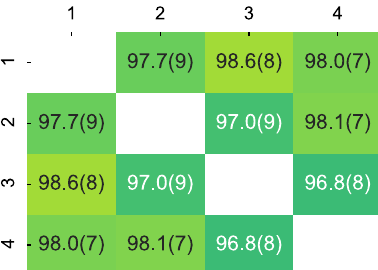
FIG. 18. Full register overlap fidelity of states produced using the AOD addressing unit in a four-ion crystal. There is no mean- ingful distinction between pair (1,4) and (4,1) as opposed to in single-site addressing. Consequently, the matrix is